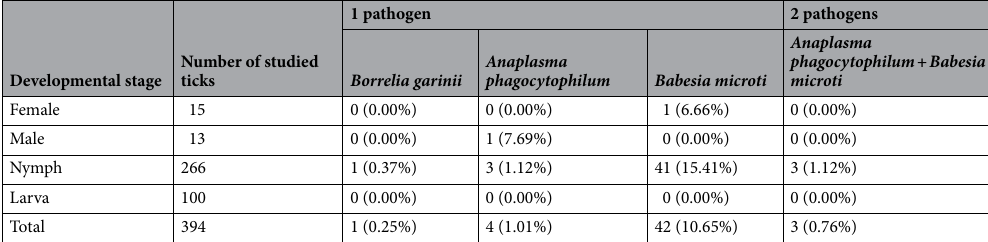
Table 2. Number and percentage of Ixodes ricinus developmental stages infected with Borrelia garinii , Anaplasma phagocytophilum and Babesia microti in the studied areas of the Wolinski National Park.